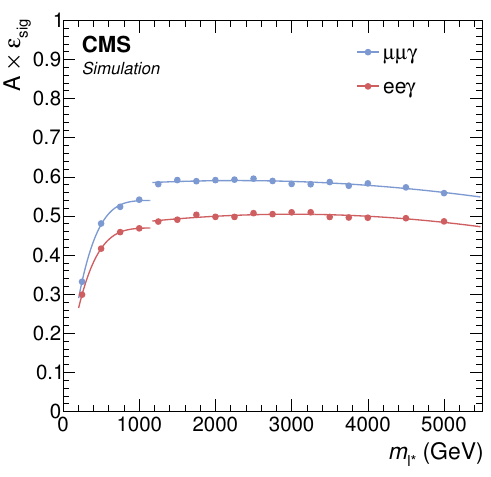
Figure 5 . The product of signal acceptance and e(cid:14)ciency as a function of the generated resonance mass for the ee (cid:13) (lower) and (cid:22)(cid:22)(cid:13) (upper) channels. Each marker denotes the value measured from the simulated signal sample at a given mass point, and the lines represent polynomial (cid:12)ts to the measured